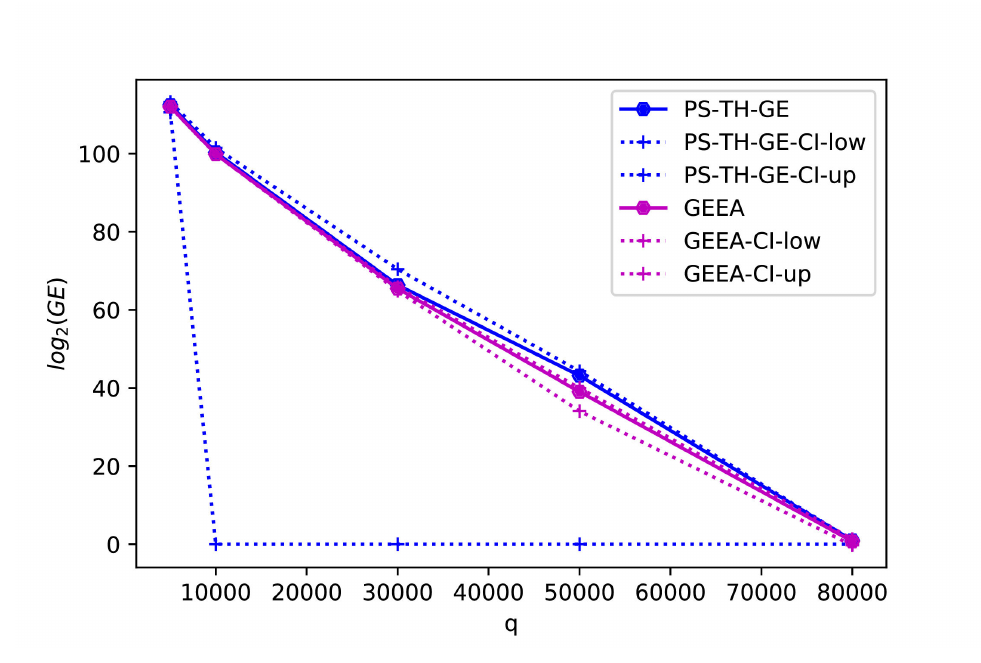
Figure 7: Comparison of PS-TH-GE and GEEA for full-key GE on the SGII-1M